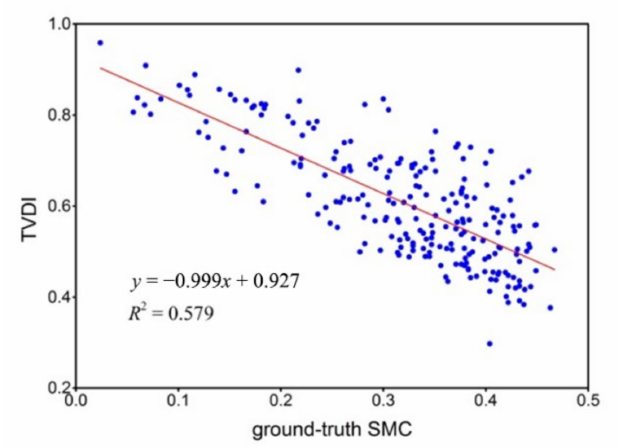
Figure 6. Scatter plot of the relationship between TVDI and ground-truth SMC for those samples with positive I i after the addition of LST as the input